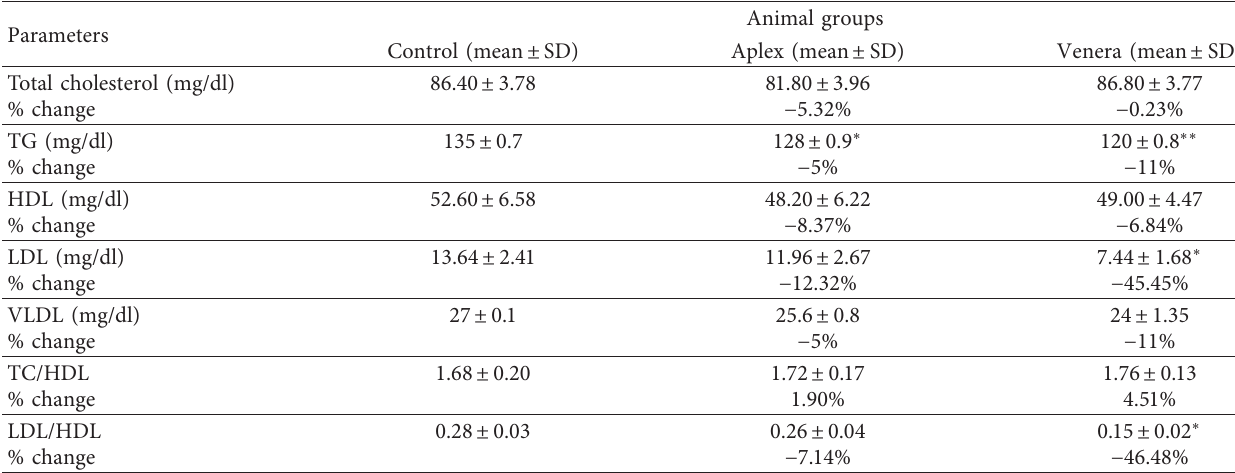
Table 5: Lipid profile indices in sera of control and treated animal groups.